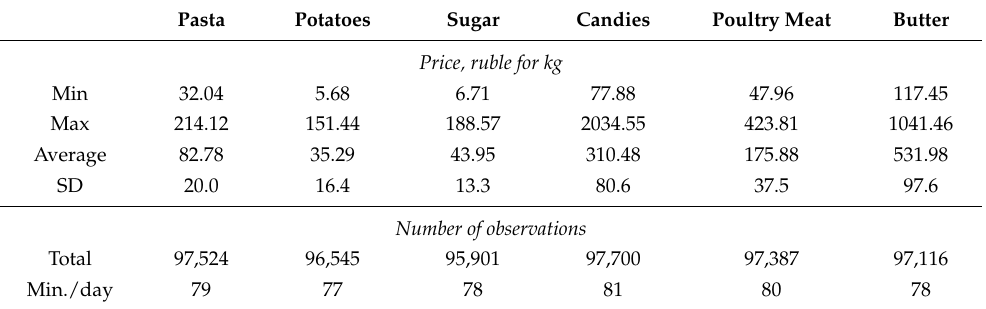
Table 1. Descriptive